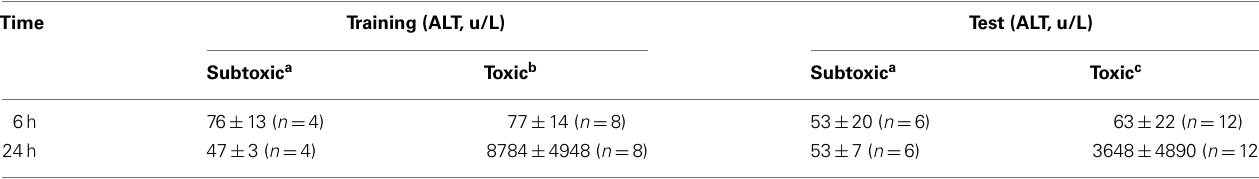
Table 1 |ALT changes at 6 and 24h afterAPAP